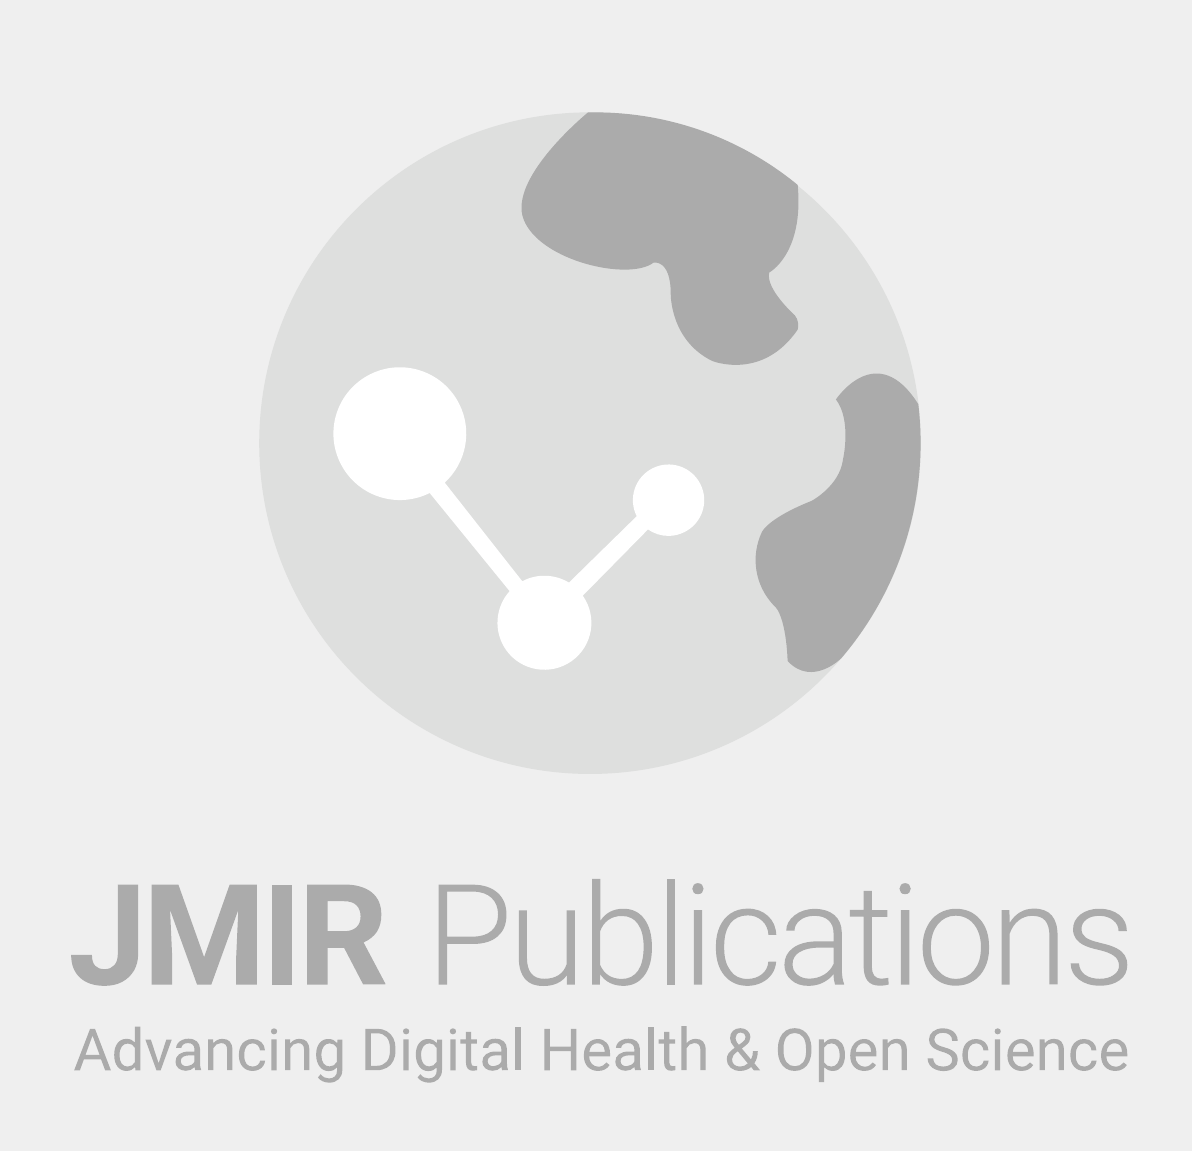
Figure 1a. Prosdex